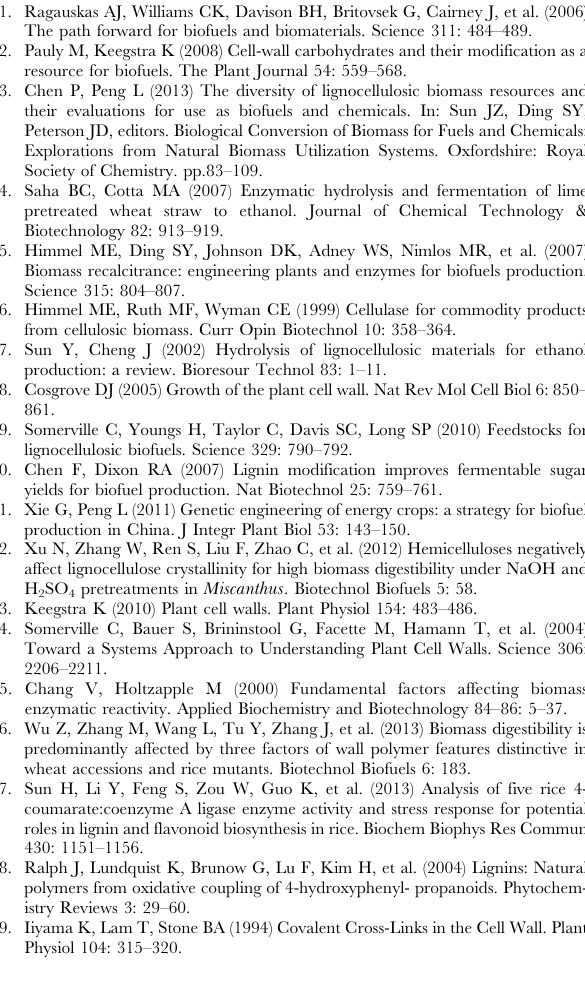
Table S1 Variation of two-forms of lignin in Miscanthus accessions (n =